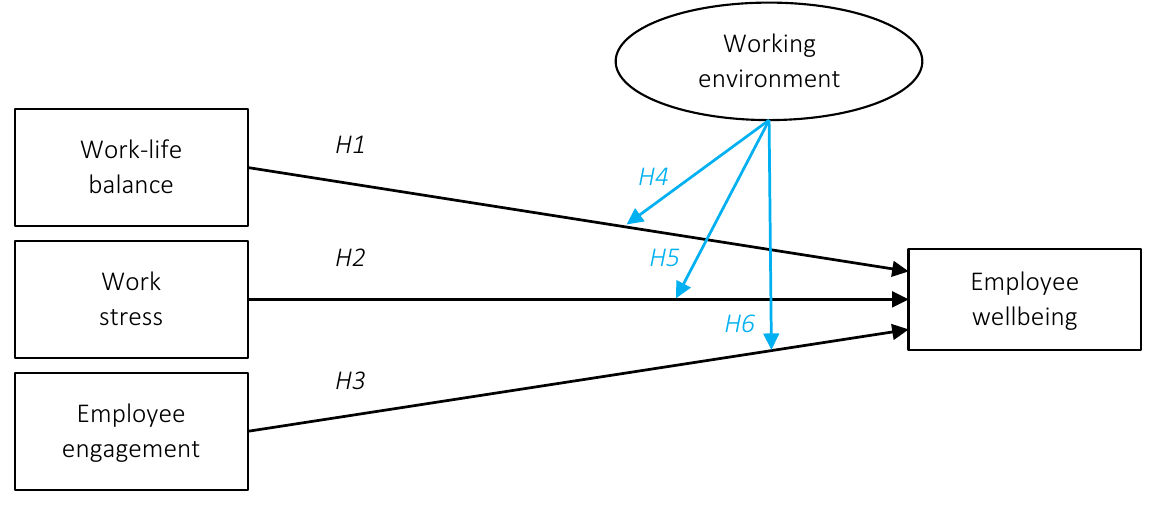
Figure 1. Research